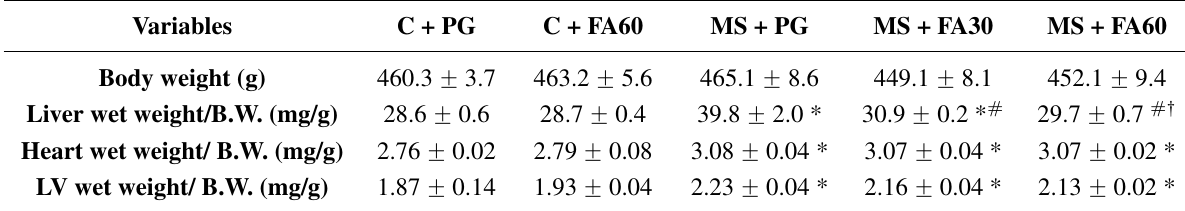
Table 2. Effect of FA on body weight and organ weight in all experimental